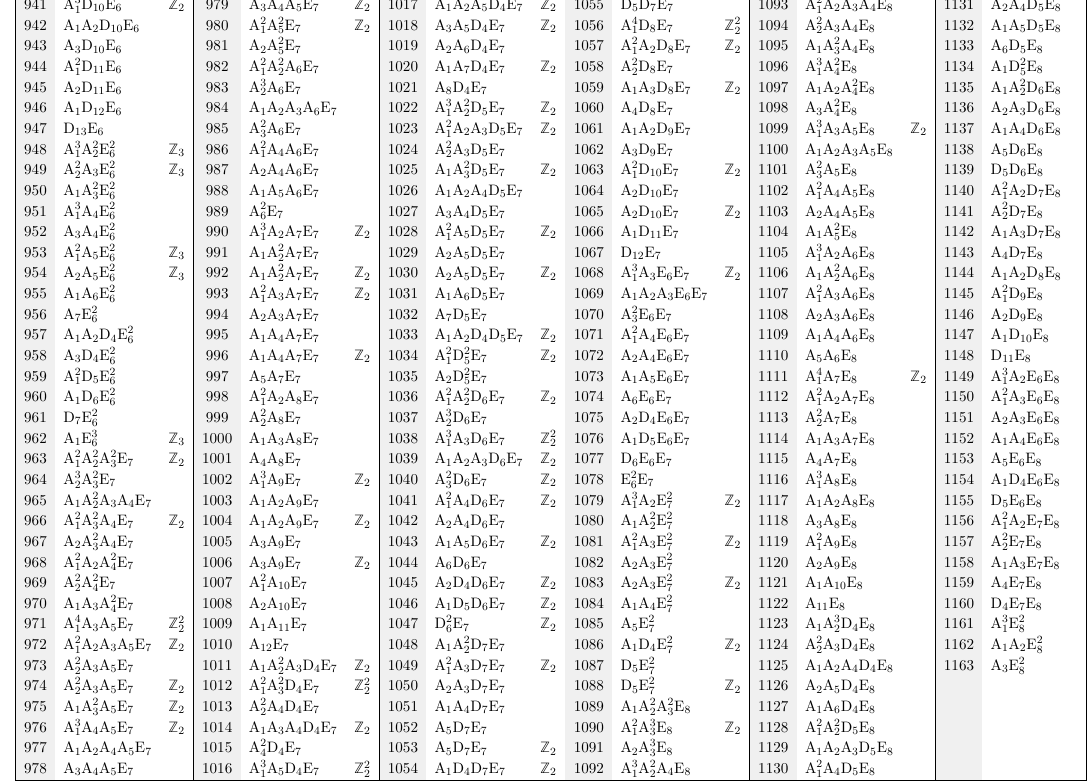
Table 4 . Algebras of maximal rank for the heterotic string on T 3